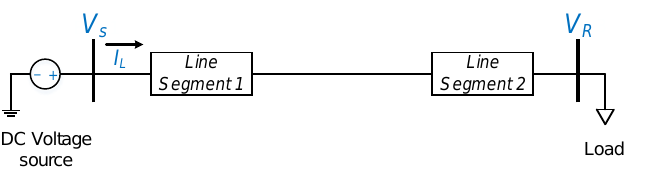
Figure 1. Simplified circuit representation of a dc line under normal operating conditions.